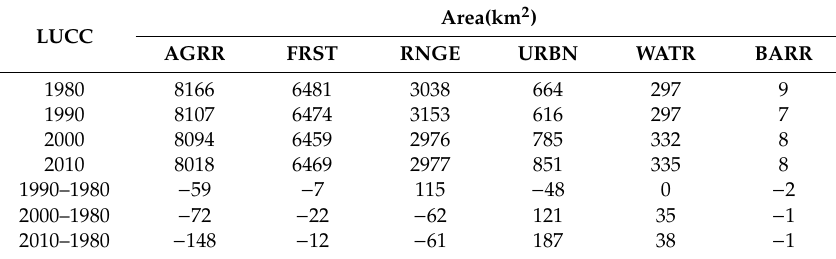
Table 3. LUCC in 1980, 1990, 2000, and 2010 relative to 1980.